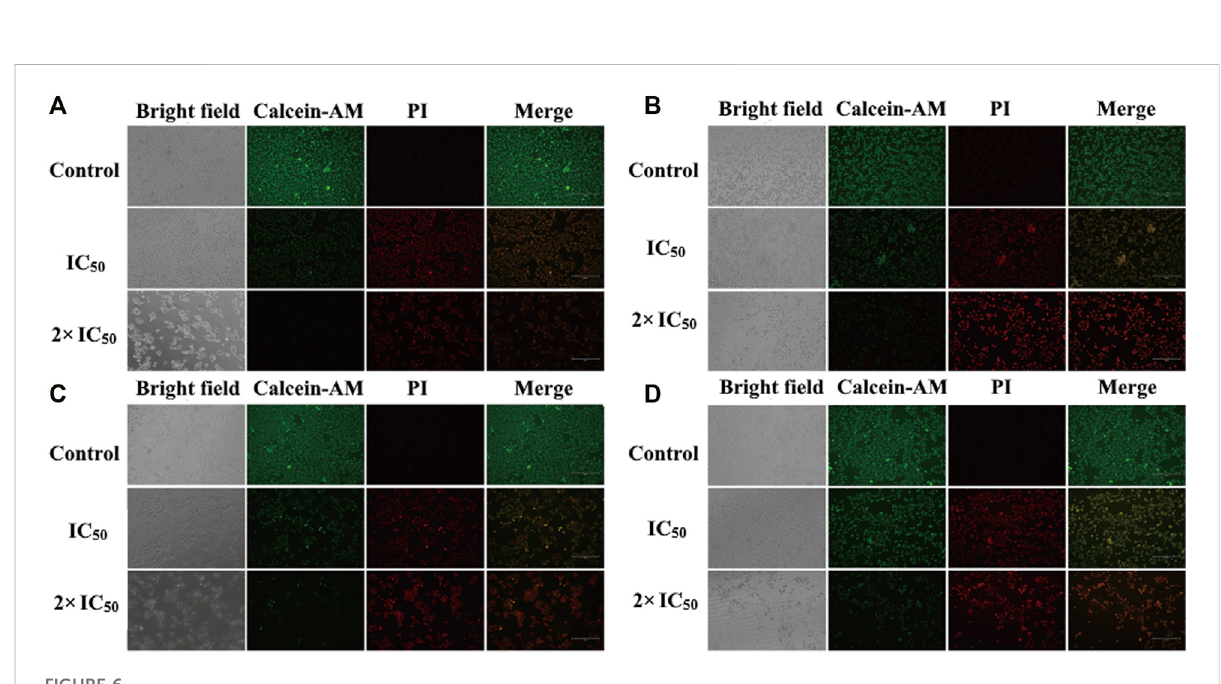
with compounds 1 or 2 NPs. These results demonstrated that the compound 1 and compound 2 NPs could induce and promote cell apoptosis of Huh7 and HepG2 cells (Figure 5). Late apoptosis of the cells treated with compound 1 NPs was detected, while both necrosis